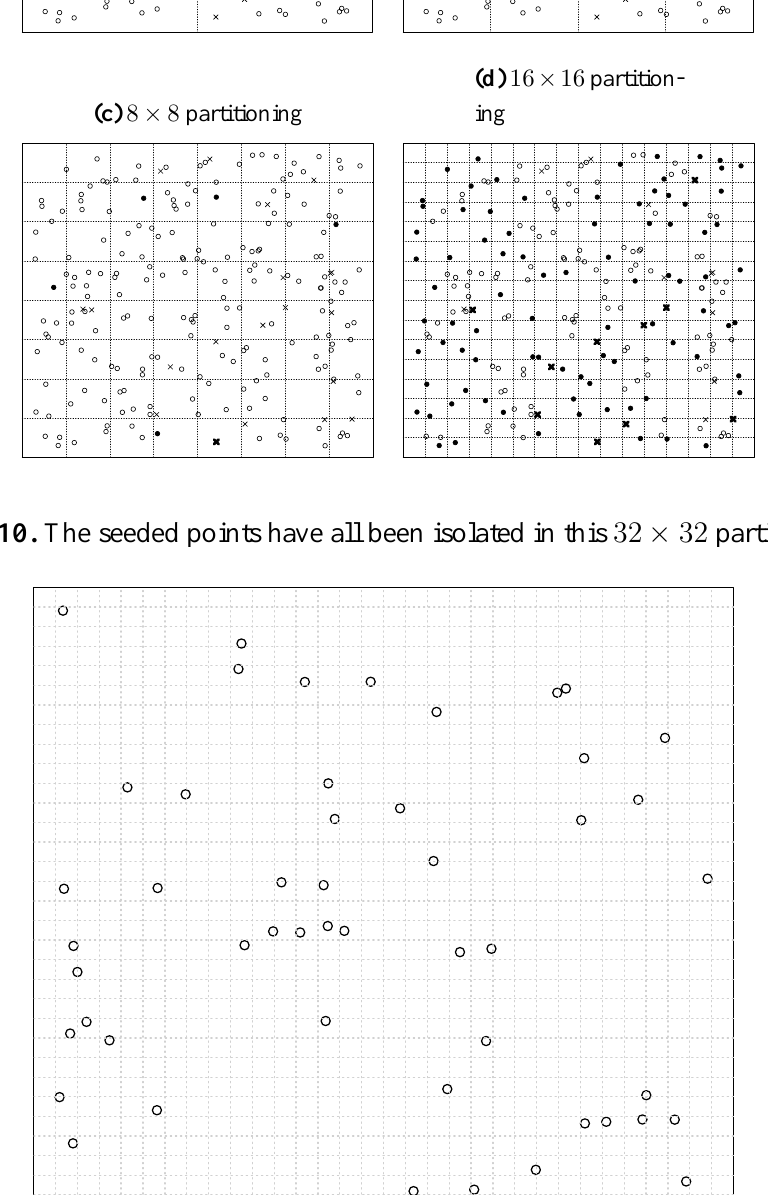
Figure 9. Recursively and uniformly partitioning on attribute subset